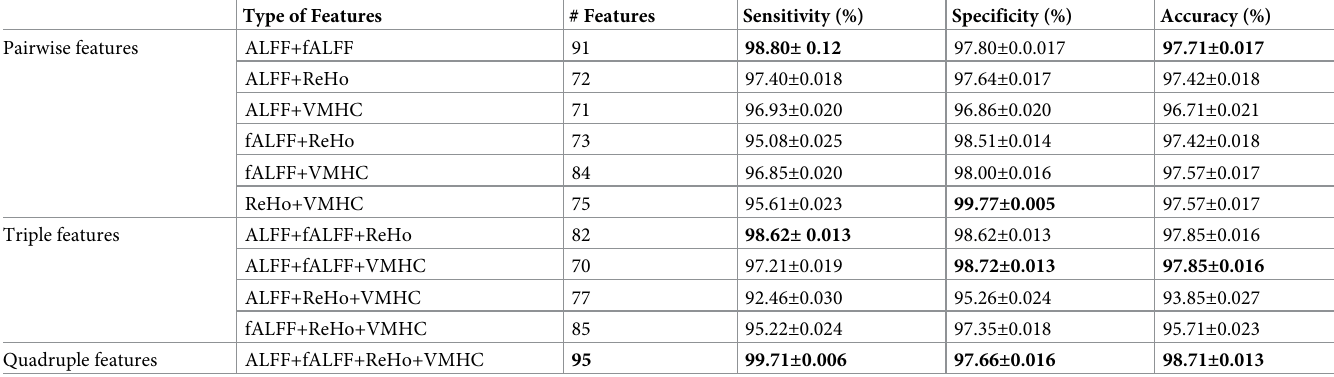
Table 4. Schizophrenia detection results with feature-level fusion of different pairwise, triple, and quadruple combinations of single feature